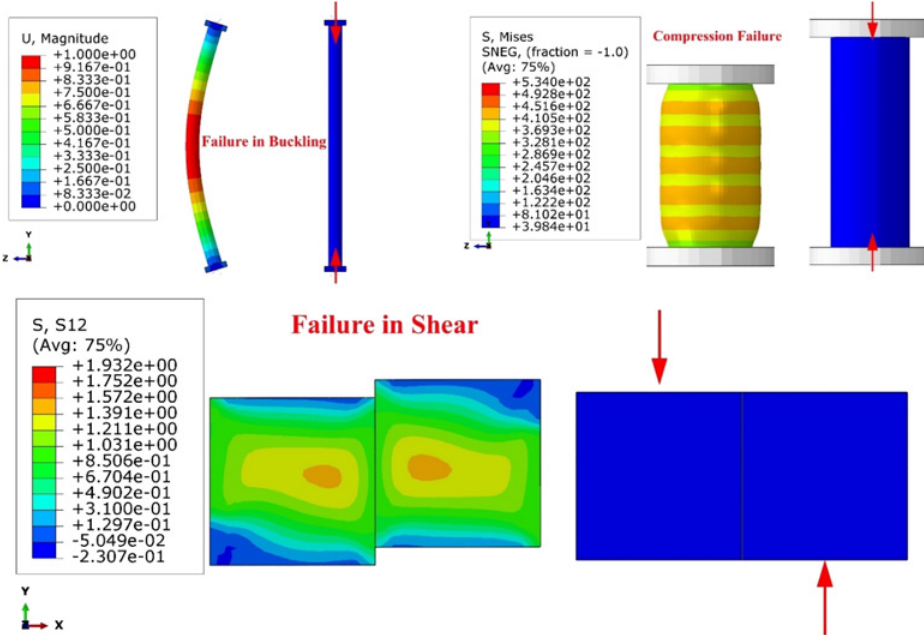
Figure 3 Different types of loadings and failures using Abaqus a finite element analysis